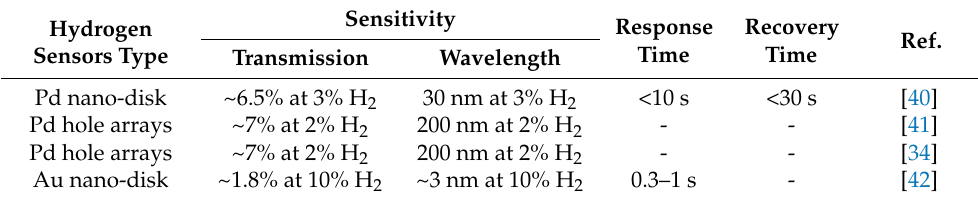
Table 1. Performances of other reported hydrogen sensors.